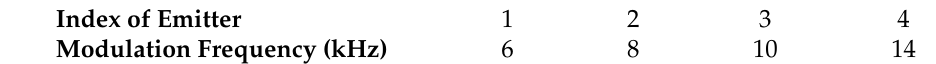
Table 1. Index and frequency modulation of the emitters.